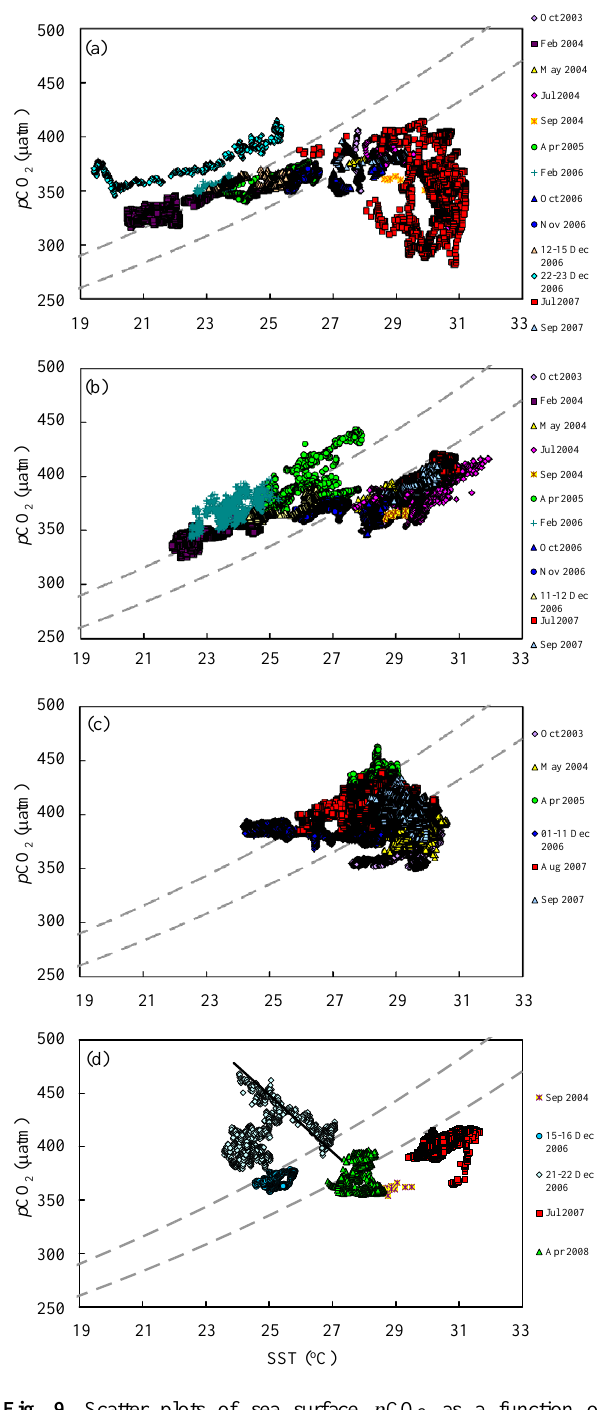
(Fig. 9a). In cold seasons the field-measured p CO 2 data were slightly higher than the predicted values based on ther- modynamically controlling functions, while in warm sea- sons relatively lower p CO 2 values were measured (Fig.